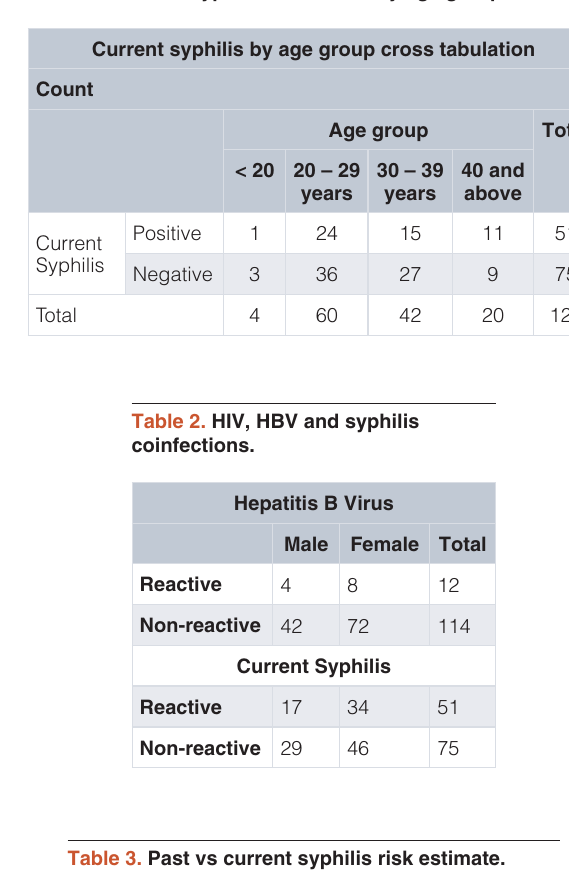
Table 1. Positive syphilis serostatus by age group.